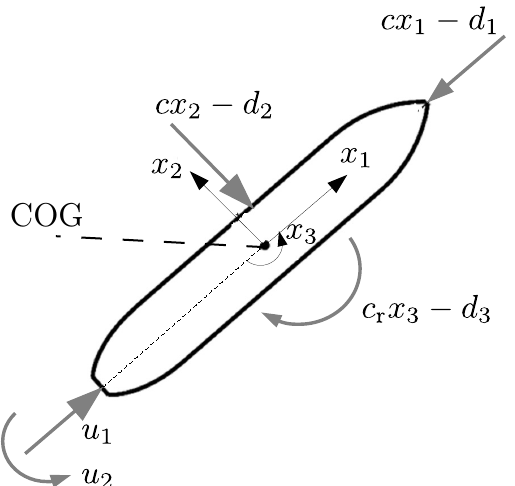
Figure 9. Definition of the velocity components in a body-fixed coordinate systems, velocity- proportional damping as well as disturbance forces and